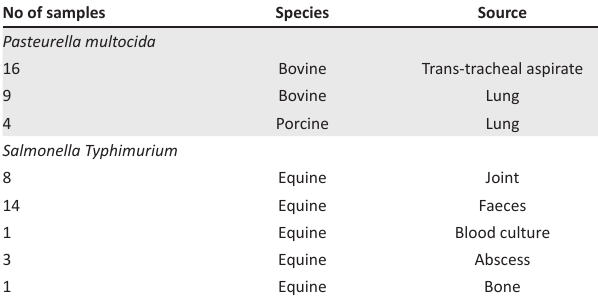
TABLE 1 : Demographics on the source for each